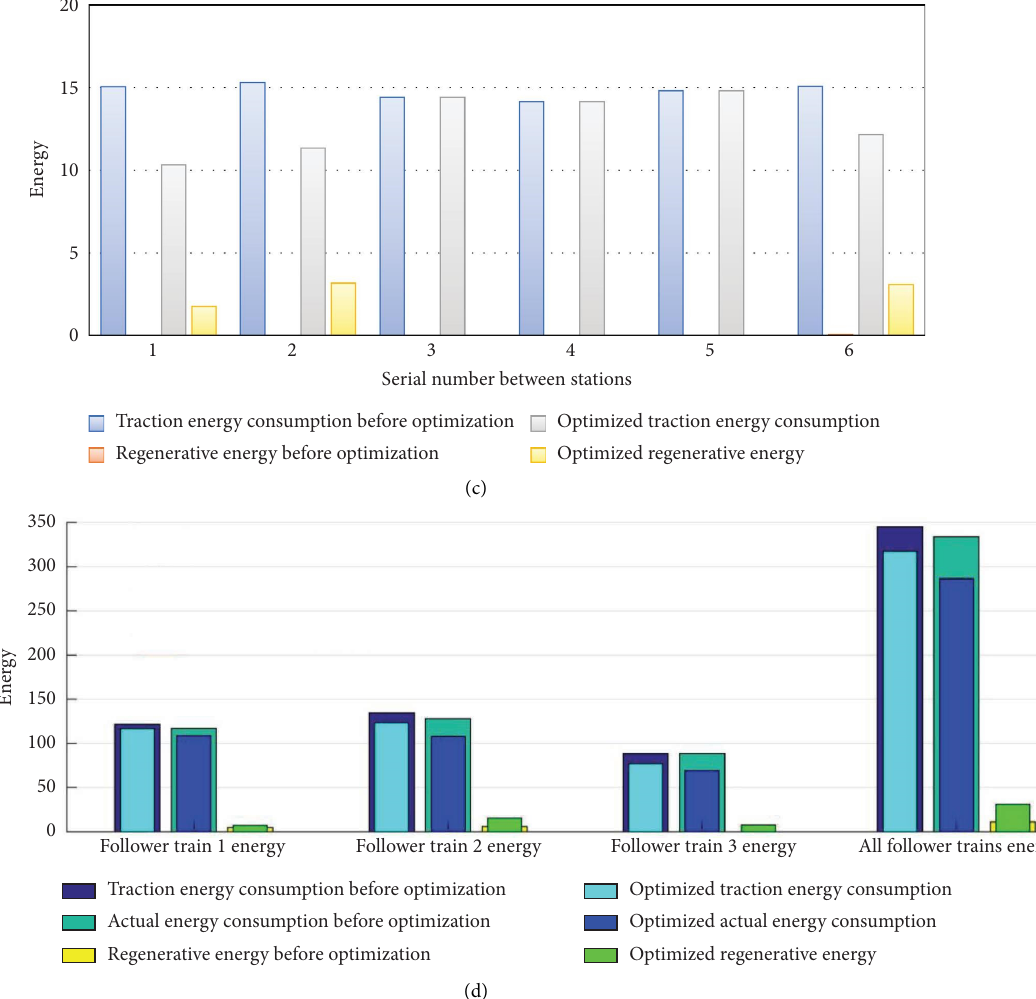
Figure 7: Energy consumption and regenerative energy utilization of follower trains: (a) energy consumption and regenerative energy utilization of train 1 between stations, (b) energy consumption and regenerative energy utilization of train 2 between stations, (c) energy consumption and regenerative energy utilization of train 2 between stations, and (d) total energy consumption and regenerative energy utilization of the following train during the running